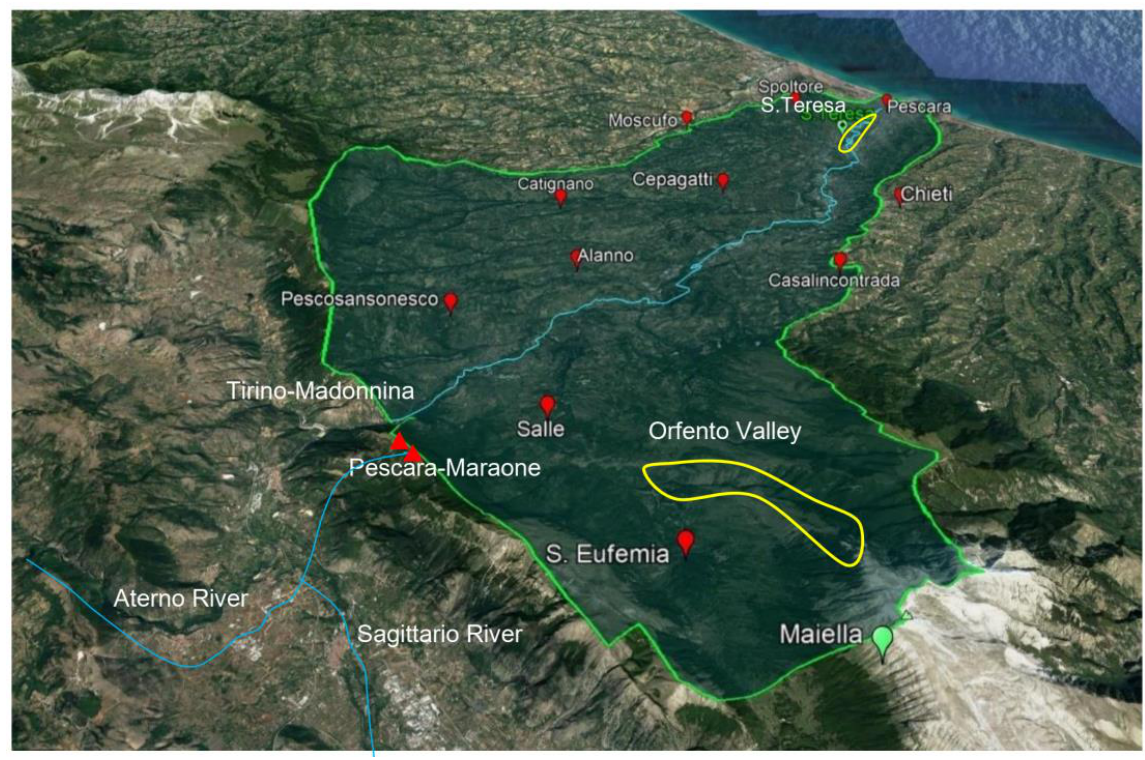
Figure 1. Basin overview. Red dots reports the pluviometric station location, small green dot reports S.Teresa River Flow rate measurement stations.